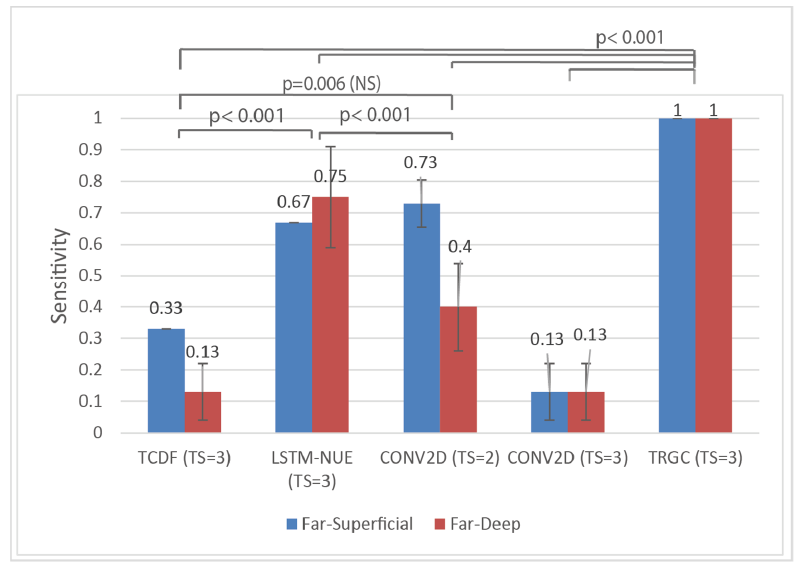
Figure 8. Mean Precision for all methods (L = 1500). Sensitivity Ranking Far–Superficial: TRGC > Conv2D (TS = 2) > LSTM-NUE > TCDF > Conv2D (TS = 3). Sensitivity Ranking Far–Deep: TRGC > LSTM-NUE > Conv2D (TS = 2) > Conv2D (TS = 3) = TCDF. Abbreviation TS = amount of time series included in the predictions. Given that the Conv2D-model based on three predicting time series resulted in a very low Sensitivity (0.13 ± 0.18) and low Precision (0.40 ± 0.55), see Figures 7 and 8, it was not considered relevant to explore the model with three predictors further in terms of connec- tivity strength (for connectivity strength per ANN, see Sections 3.1.2 to 3.1.4). This deci- sion was supported by the results of a Scheirer–Ray–Hare Test with model and dipole condition as factors and with follow-up Mann–Whitney U tests (Bonferroni-corrected).